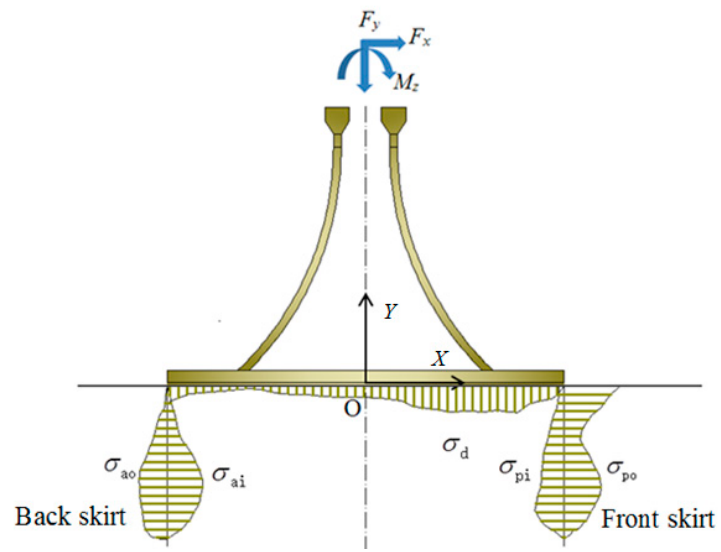
Figure 17. Soil pressure distribution of CBF under an ultimate load of a 50-year return period.